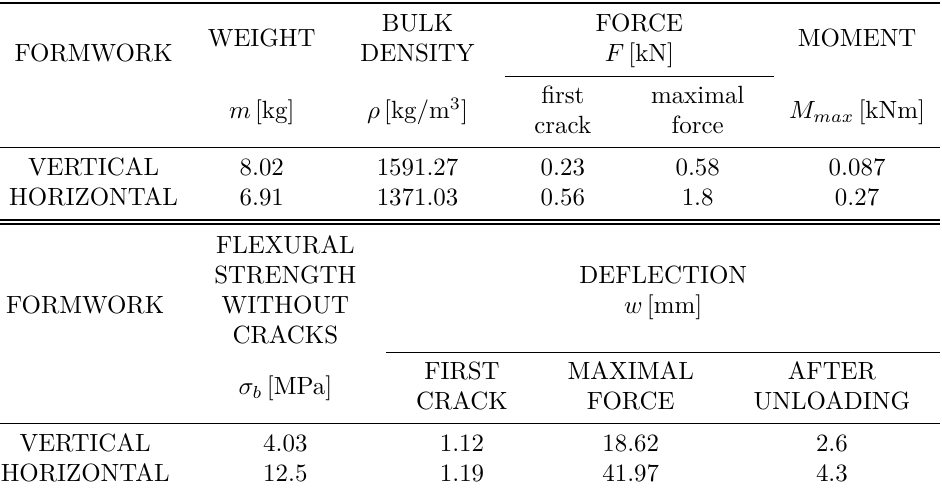
Table 2. Flexural test results for TRLC slabs with 3D glass textile.